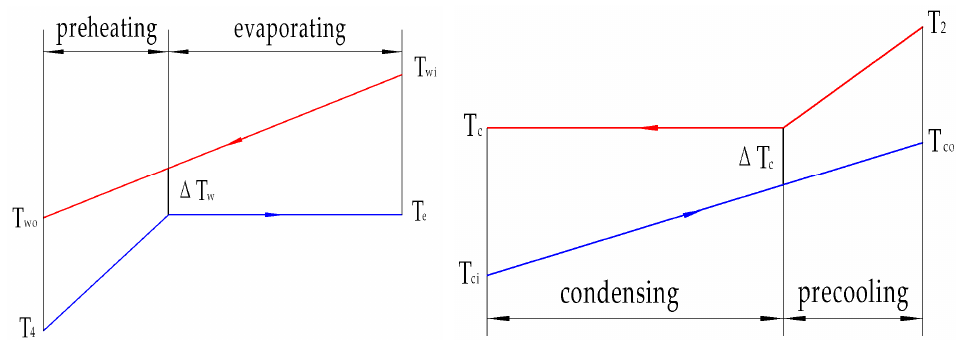
Figure 2. The phase-change process in the evaporator and condenser.